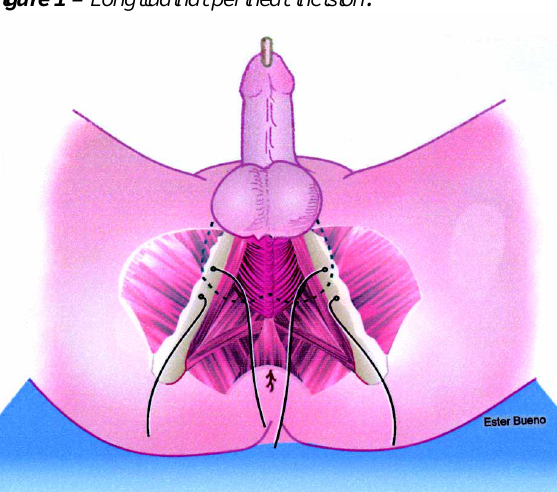
Figure 3 – Aponeurotic flap with wires passed in its angles.